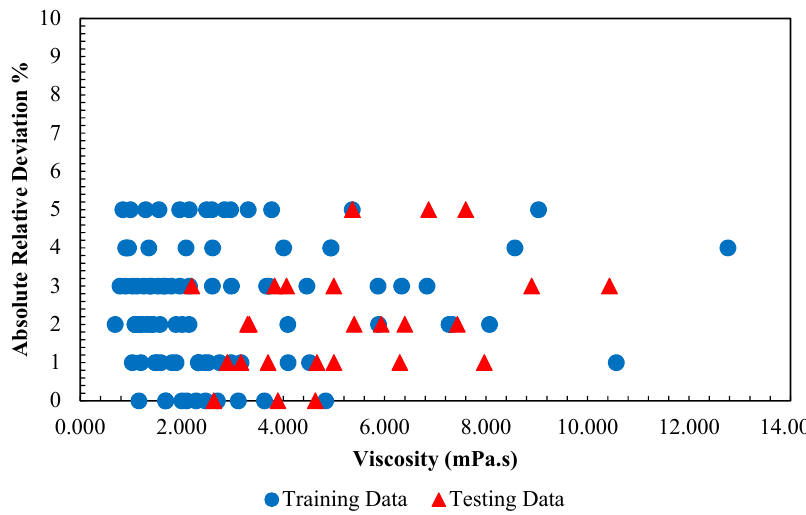
Figure 8. Absolute relative error distribution of the obtained outputs from LSSVM model versus corresponding viscosity of Fe 2 O 3 /ethylene glycol-water nanofluid data points.